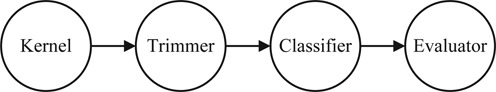
The BetaCavityWeb server's components and computational flow.